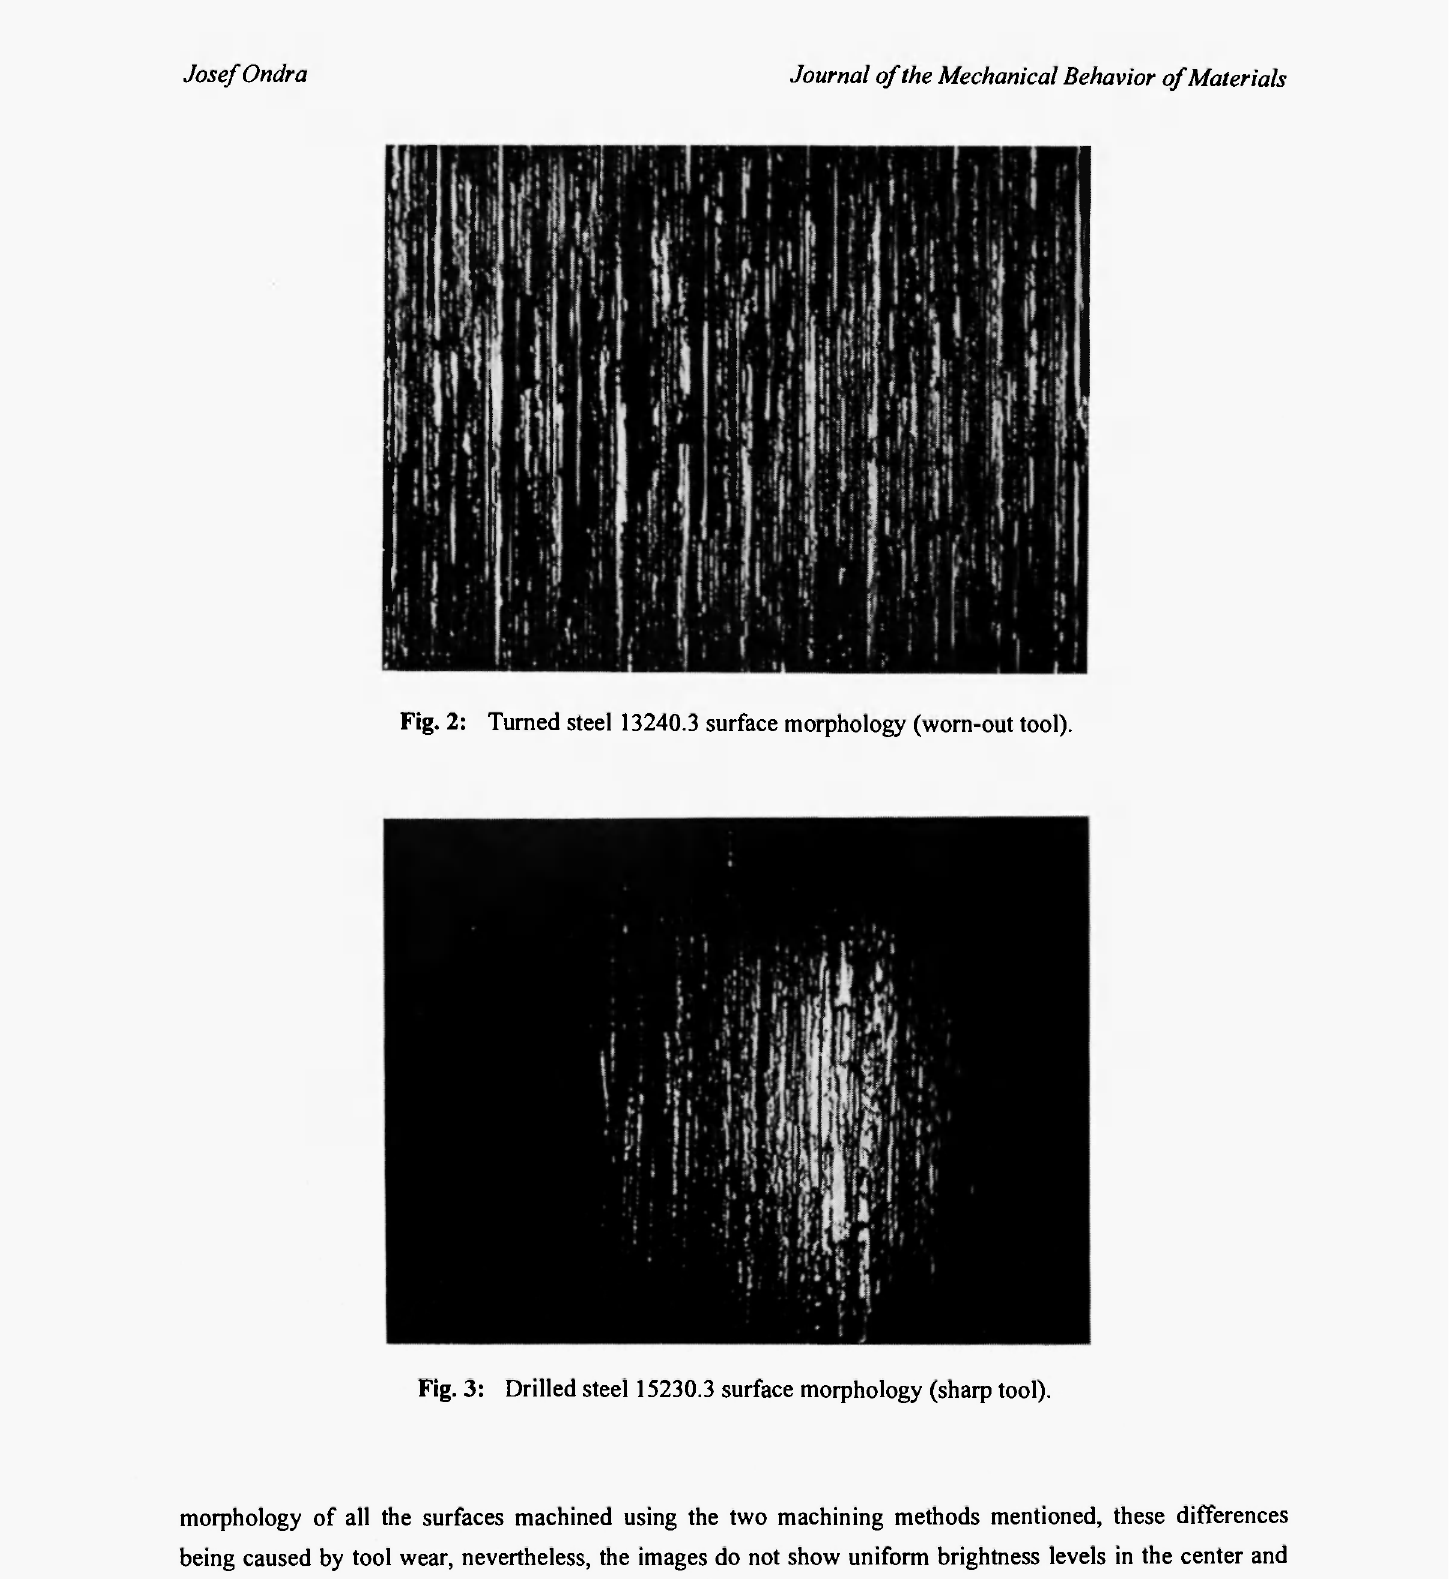
Fig. 3: Drilled steel 15230.3 surface morphology (sharp